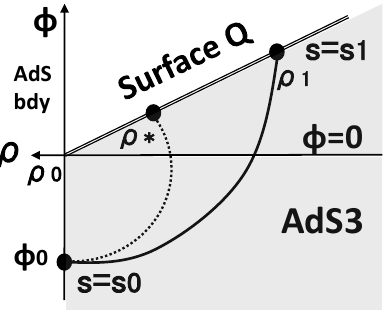
Figure 2 . A sketch of a Wilson line which computes the entanglement entropy in AdS/BCFT. The colored region is the physical spacetime for the AdS/BCFT. The dotted curve describes the minimal length one. We omit the time direction. In CS gravity description, for any choices of a point Q the Wilson line takes the same expectation value once we impose our Neumann-Dirichlet boundary